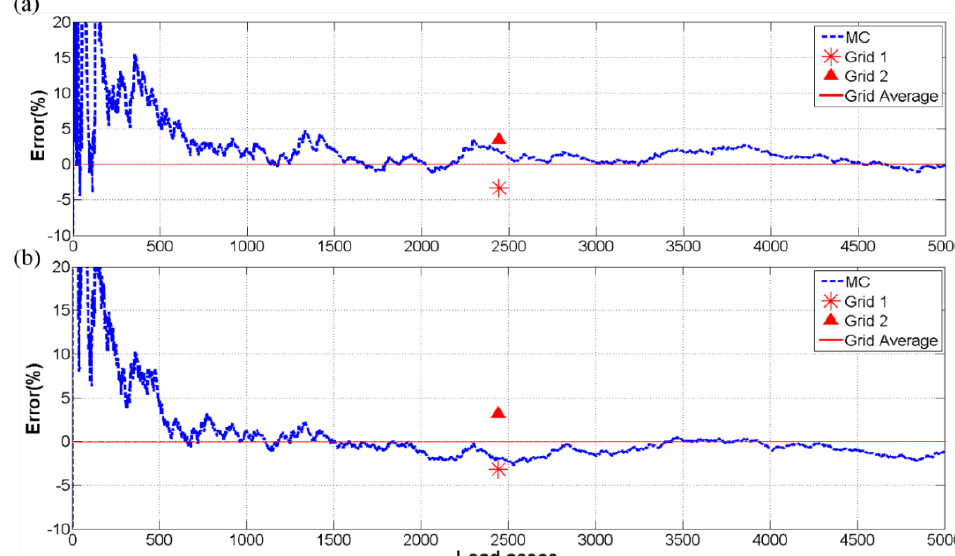
Figure 11. CFD error estimation of the grid-based and MC methods for ( a ) the K joint and ( b ) the KK joint when an average of two grid-based results (grid average) was selected as the data.